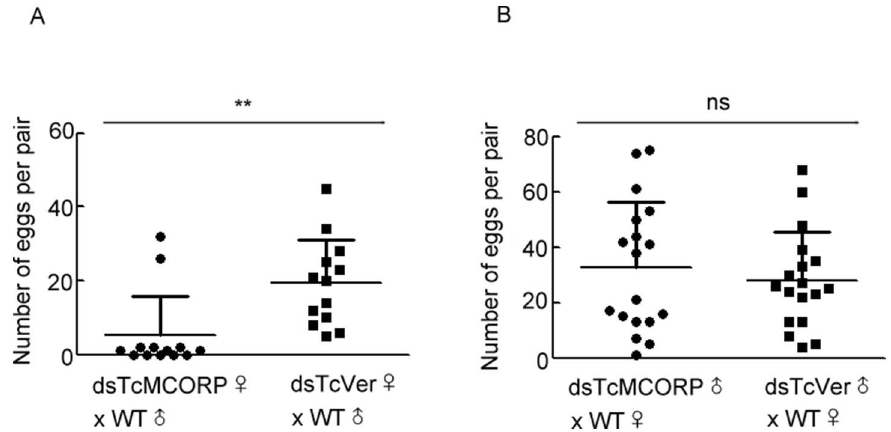
Figure 7. Effect of TcMCORP knockdown on egg number. dsRNA targeting TcMCORP or TcVer was injected into T. castaneum pharate pupae. Injected females and males were sexed at the pupal stage. At 4 days after adult eclosion, the RNAi insects were mated with wild type (WT) insects on a single pair basis. The eggs produced from each pair were counted. Pairwise differences in egg numbers were assessed by performing a Mann- Whitney test. Bars represent mean + standard deviation. A) Comparison of the number of eggs produced from dsTcMCORP R 6 WT = crosses and dsTcVer R 6 WT = crosses. The latter group served as a control. A significant difference was observed (**=p , 0.01, n=13). B) Comparison of the number of eggs produced from dsTcMCORP = 6 WT R crosses and dsTcVer 6 WT R crosses. The latter group served as a control (ns=not significant, n=18).